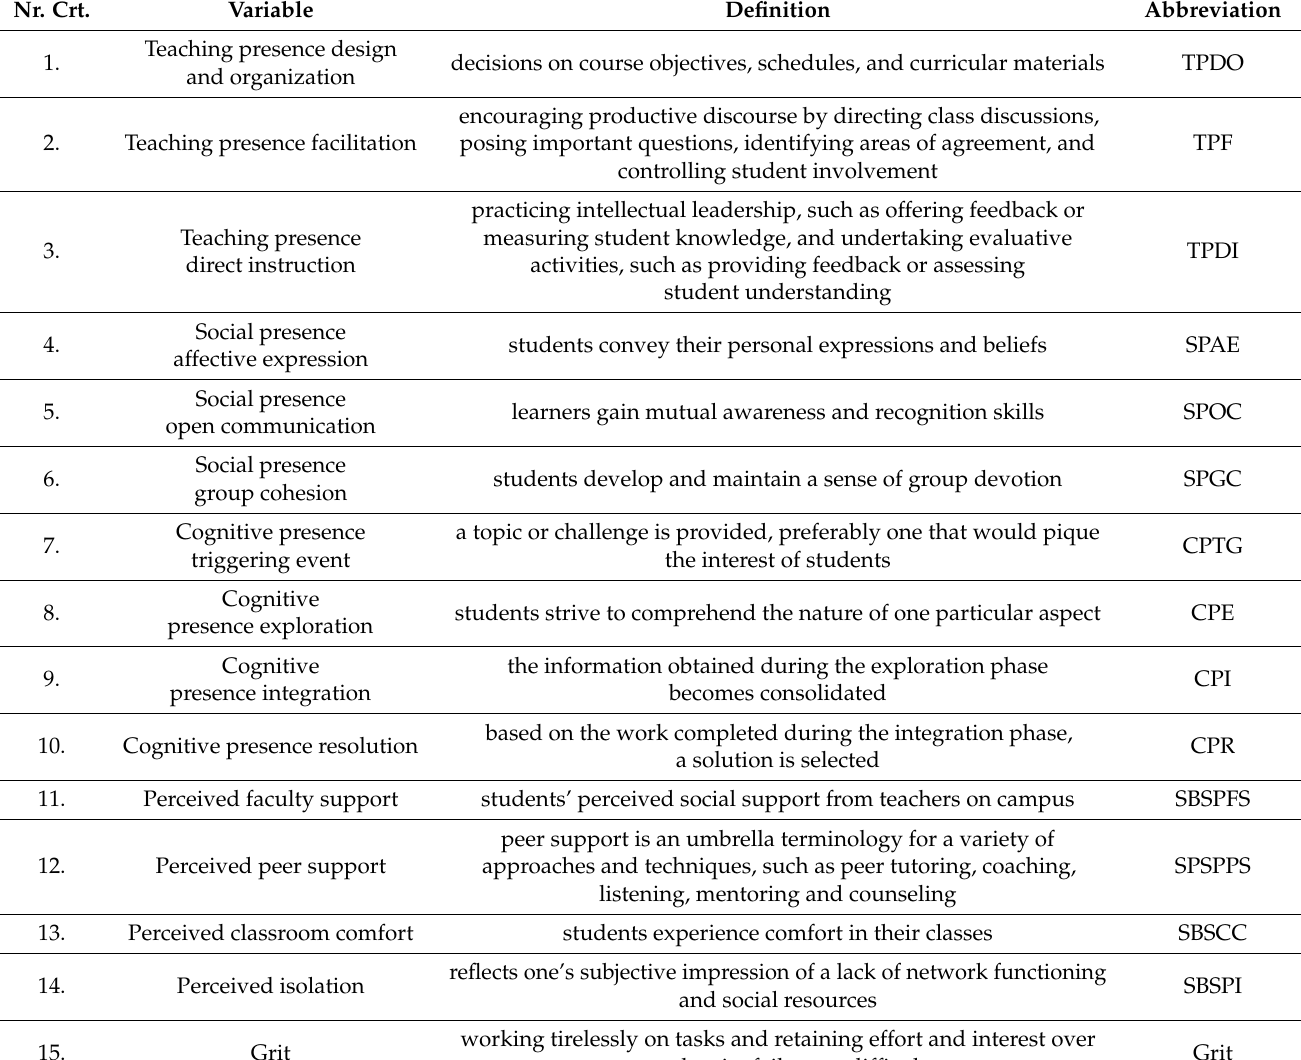
Table 1. Variables used in the